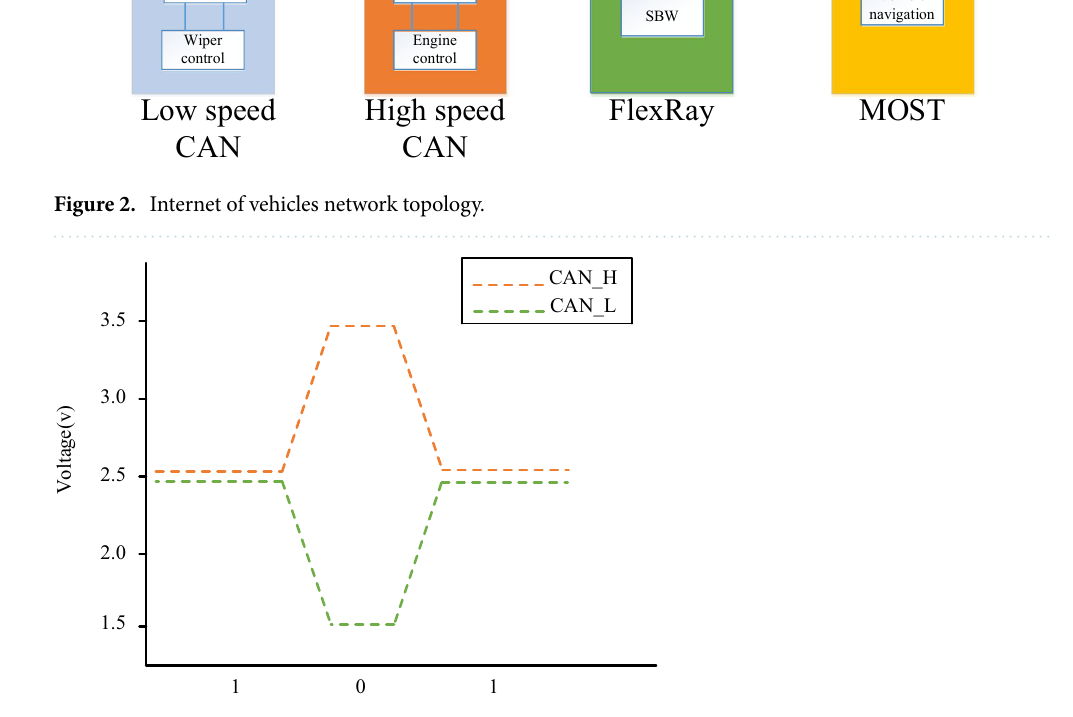
Figure 3. Signal logic of CAN bus, where the orange dotted line represents the high level bus and green dotted line represents the low level